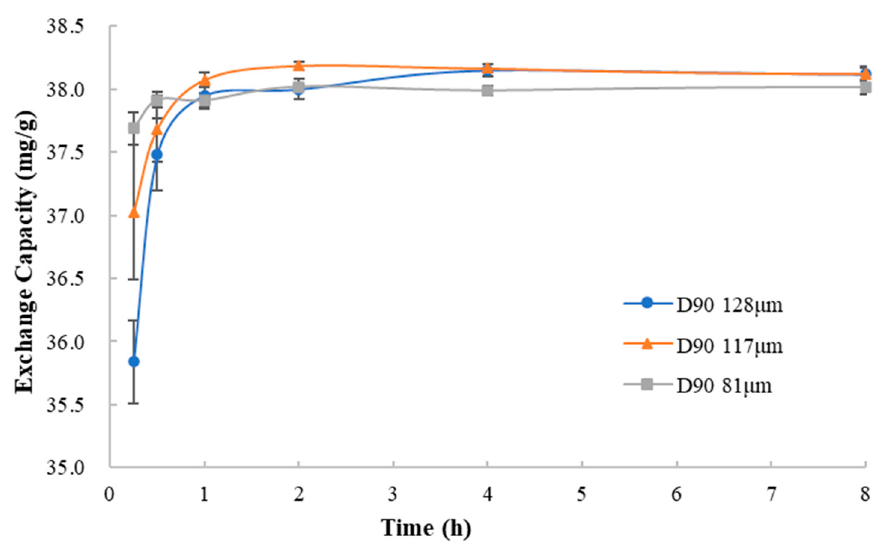
Figure 13. The curves of the exchange capacity vs. mixing time with the resins of different particle size.